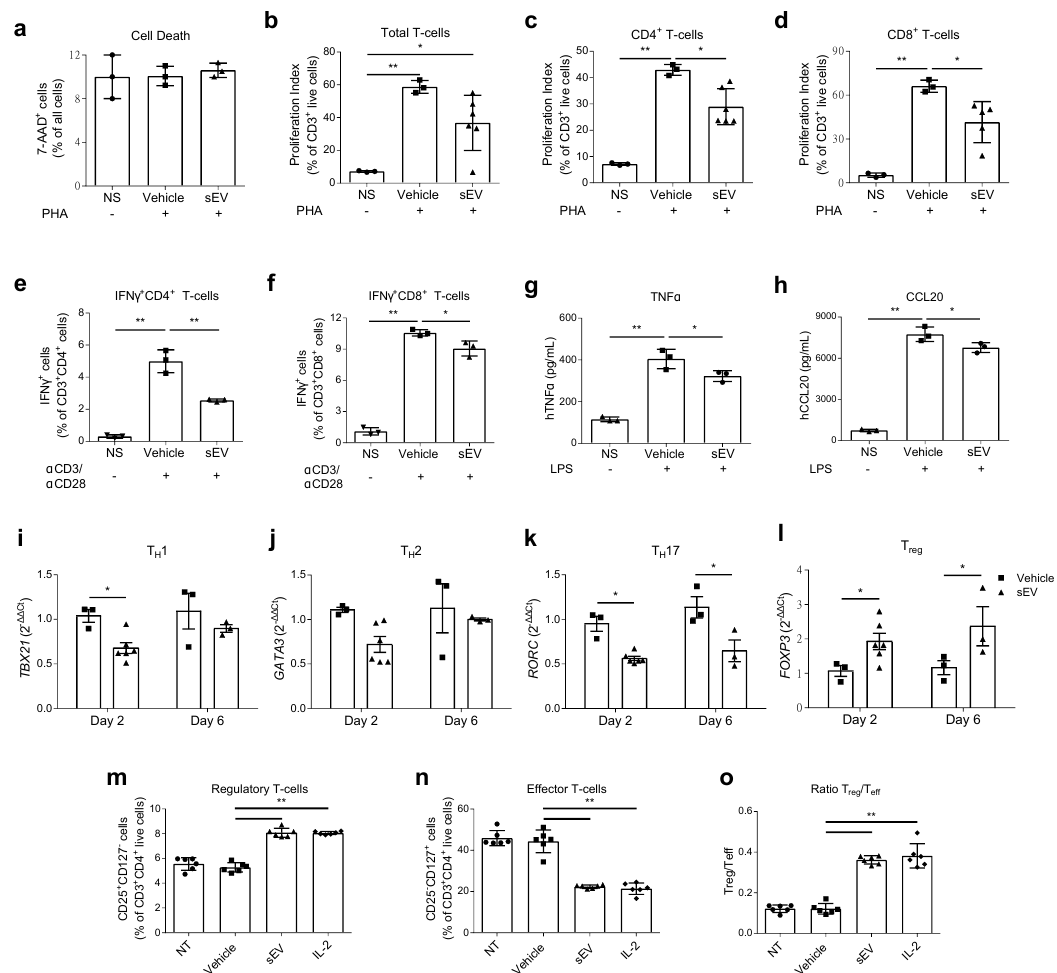
Figure 2. UCB-MNC-sEV’s immunomodulatory effects on T-cells in vitro . ( a – f ) Human PBMC, stimulated with PMA or α CD3/ α CD28 as indicated, were incubated with a single dose of UCB-MNC-sEV at 1 × 10 10 particles/mL for 6 days, followed by flow cytometry analysis ( n ≥ 3). ( g , h ) TNF α and CCL20 release by LPS-stimulated PBMC after a 24 h incubation with 1 × 10 10 particles/mL UCB-MNC-sEV ( n = 3). ( i – l ) Relative expression of transcription factors by PBMC incubated with UCB-MNC-sEV for 2 or 6 days ( n ≥ 3). Cells were sorted based on FSC, SSC, CD3, and CD4, prior to RNA extraction. ( m–o ) Phenotyping of α CD3/ α CD28-activated PBMC, after 6 days of incubation with UCB-MNC-sEV at 1 × 10 10 parti- cles/mL or IL-2 (100 IU/mL) and TGF- β (5 ng/mL) ( n = 6). All results are presented as mean ± SD. * p ≤ 0.05, ** p ≤ 0.01. NS, non-stimulated; NT,